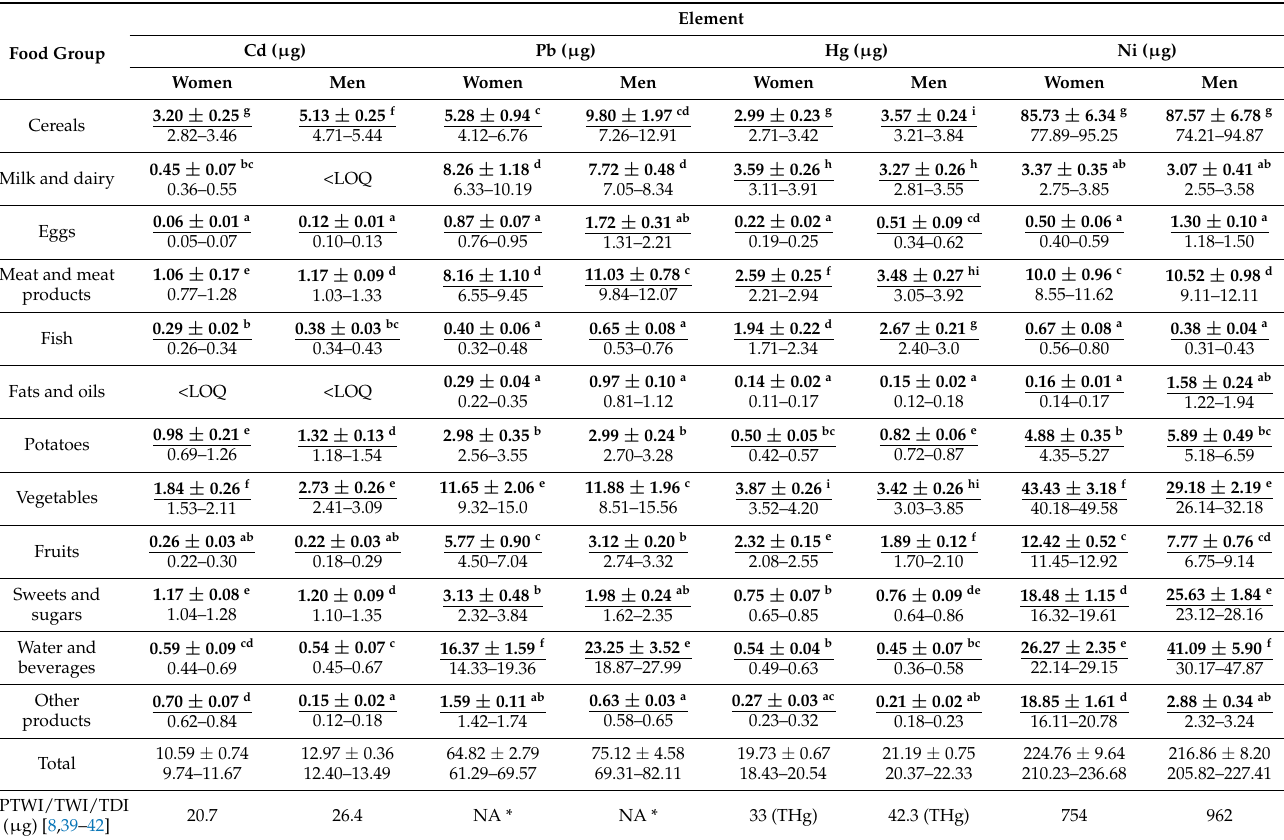
Table 3. Daily intake of toxic heavy metals with particular food groups. Each value represents mean ± SD, min, and max values. The means not sharing the same letter in a column are significantly different at p ≤ 0.05. The underlined means are significantly different between women and men at p ≤